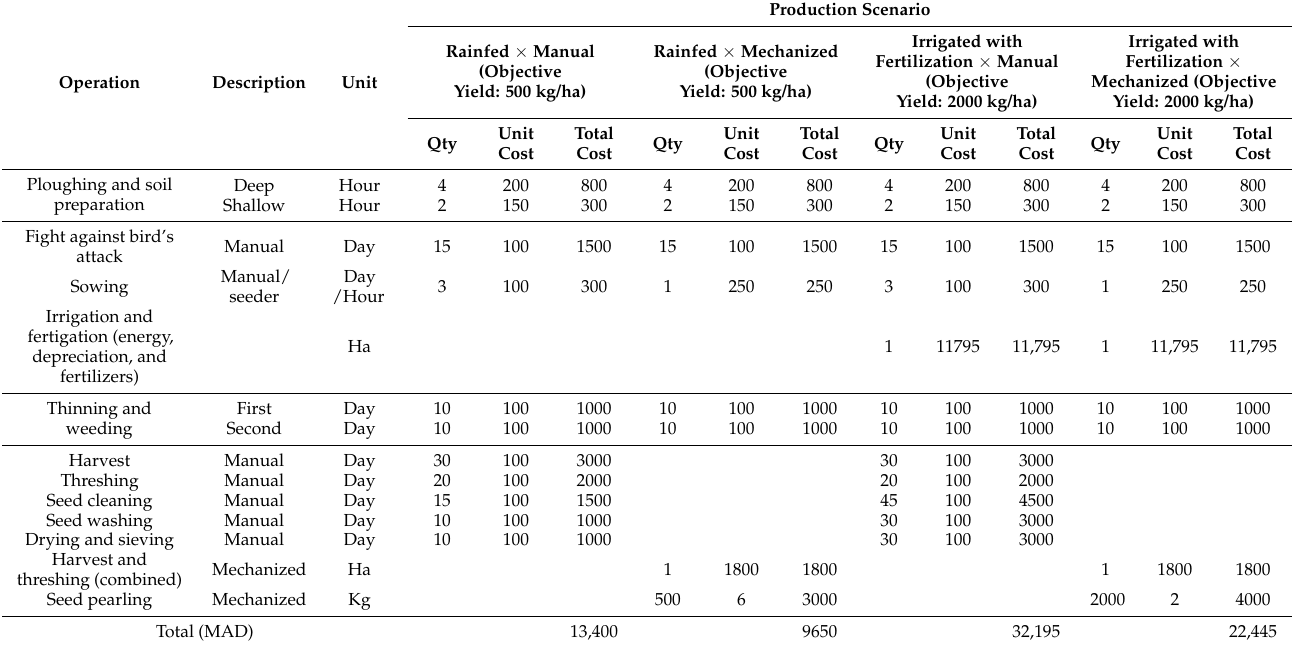
Table 5. Cost breakdown for quinoa cultivation and seed processing operations. 1 USD= 9